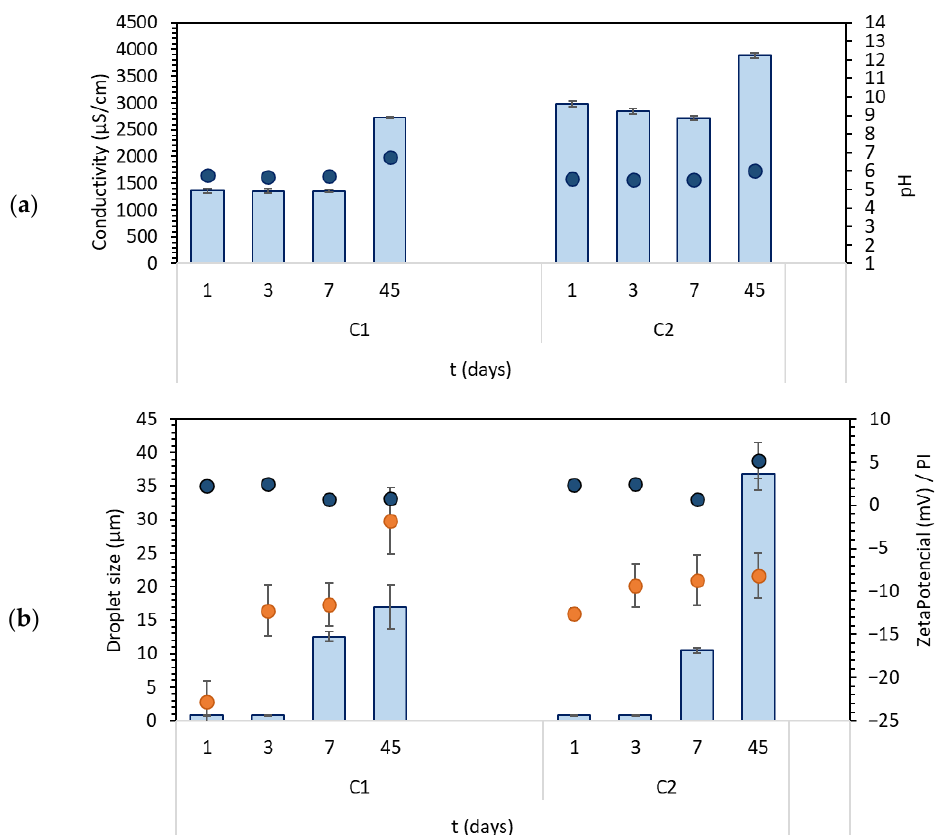
Figure 5. ( a ) pH (dots) and conductivity (bars) and ( b ) droplet size (blue bars), zeta potential (orange dot), and PI (blue dot) for formulations C1 and C2 during the storage period (t = 1, 3, 7, 45 days).